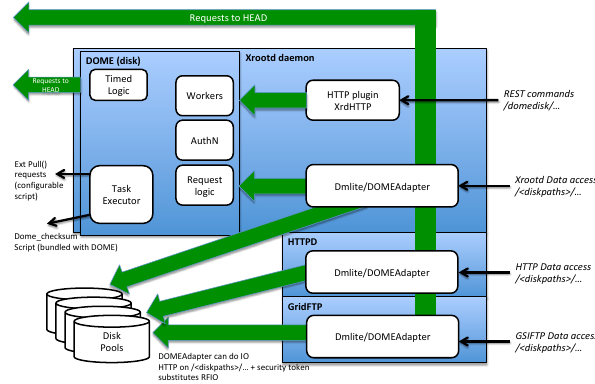
Figure 1. Simplified diagram of DOME in a disk